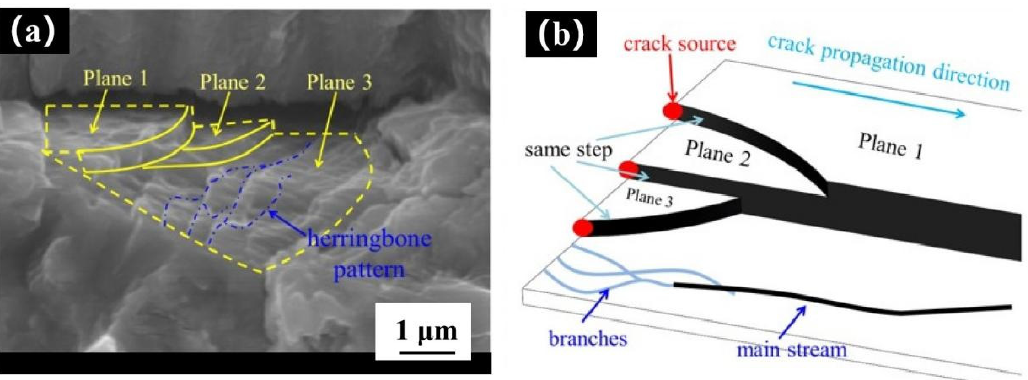
Figure 15. ( a ) SEM image of cleavage step, ( b ) schematic diagram of the formation mechanism of cleavage steps.